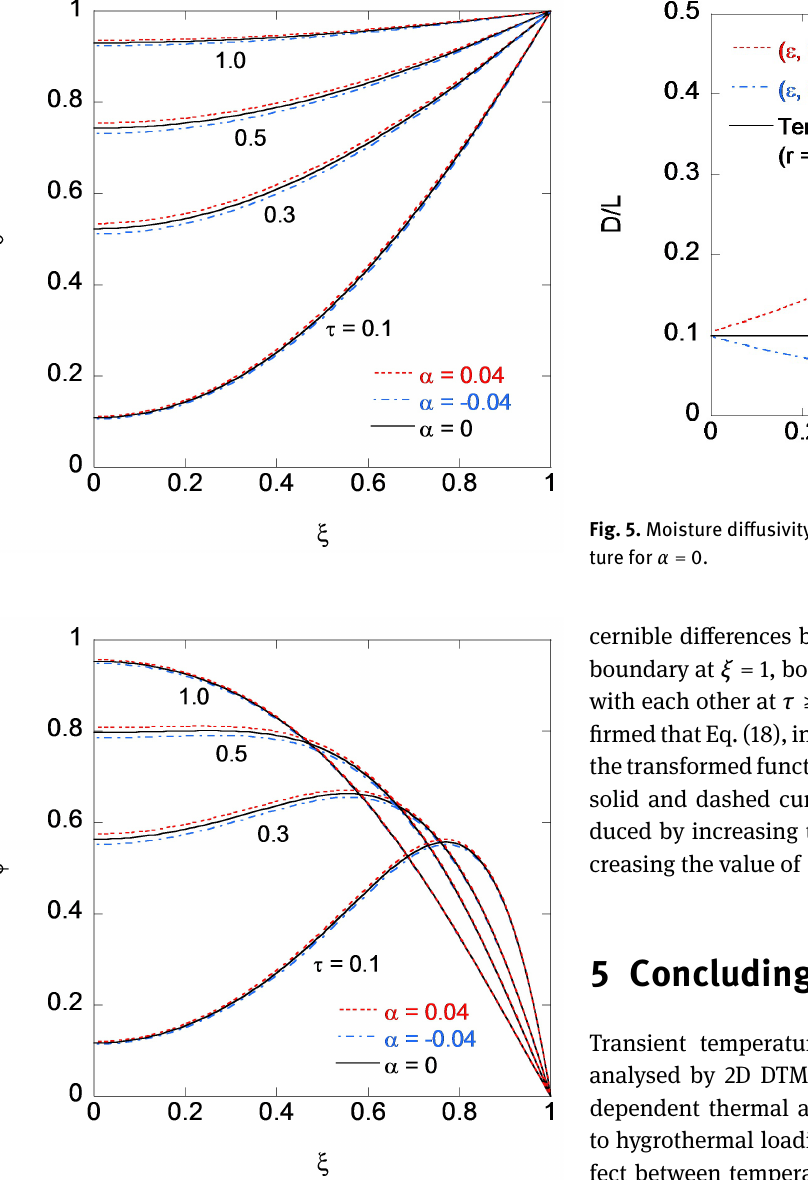
cernible differences between them are observed near the boundary at ξ = 1, both curves are in excellent agreement with each other at τ ≥ 0.5. Consequently, it has been con- firmed that Eq. (18), including Eq. (19), properly represents the transformed function of u . The differences between the solid and dashed curves at small values of τ can be re- duced by increasing the spatial division number (i.e. de- creasing the value of G